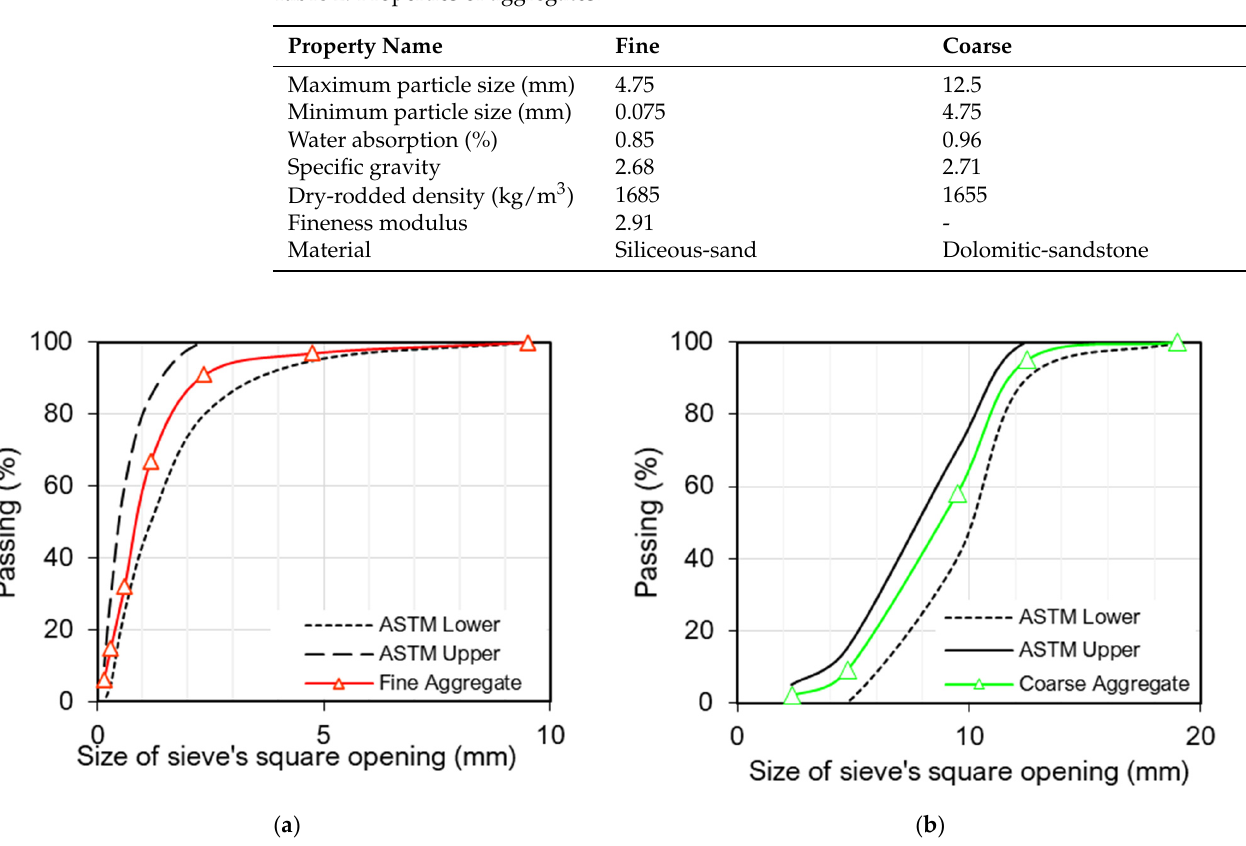
Figure 2. Aggregate size gradation charts within limits of ASTM C33 [54]: ( a )Fine aggregate; ( b ) Coarse aggregate.